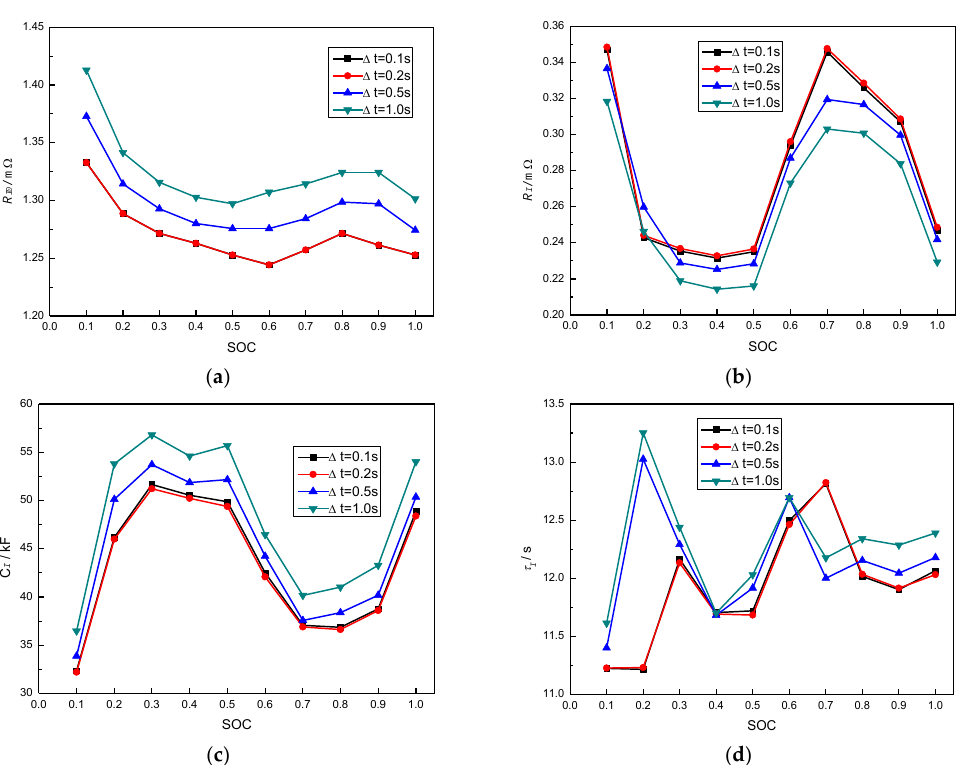
SOC Figure 10. Change curve of Voc with SOC. 4.2.2. Resistance and capacitance values of 1-RC circuit model Figure 11a – c, respectively, show the identified parameter curves with SOC for vari-